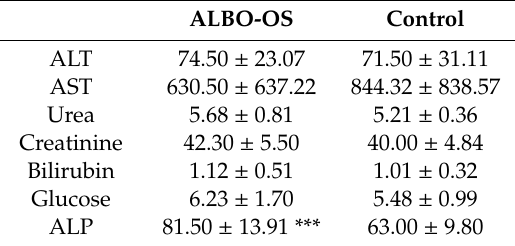
Table 2. Results of analysis of biochemical parameters; the values are shown as mean ± SD (*** p < 0.001; t